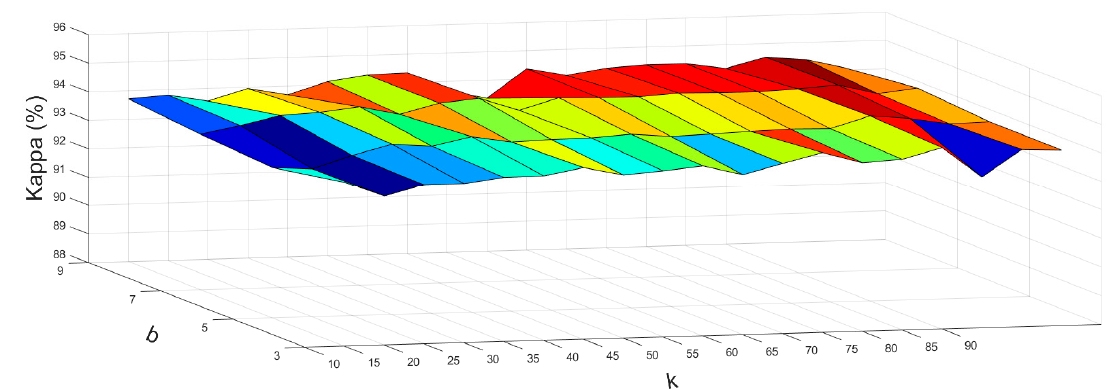
Figure 7. Parameter selection experiment for selecting b and k on the Farmland data set.